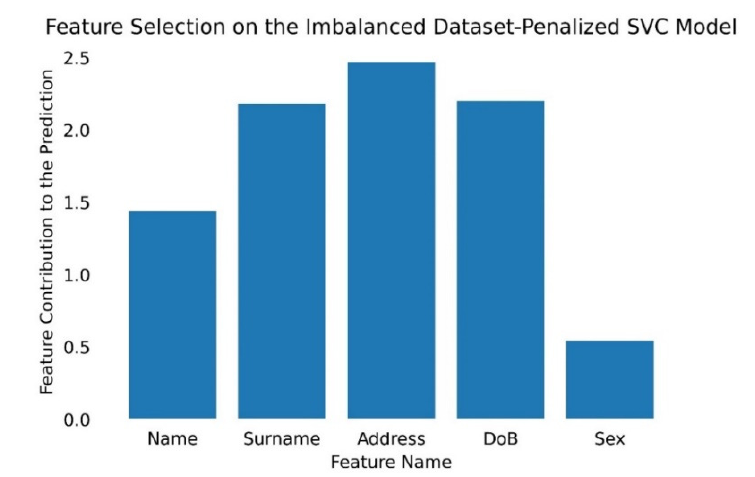
Figure 5. Feature importance of the RF model using the imbalanced dataset as input.